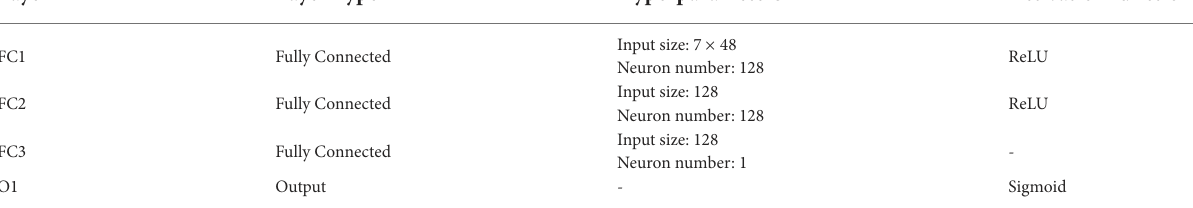
TABLE 3 HyperparametersofnetworkA.